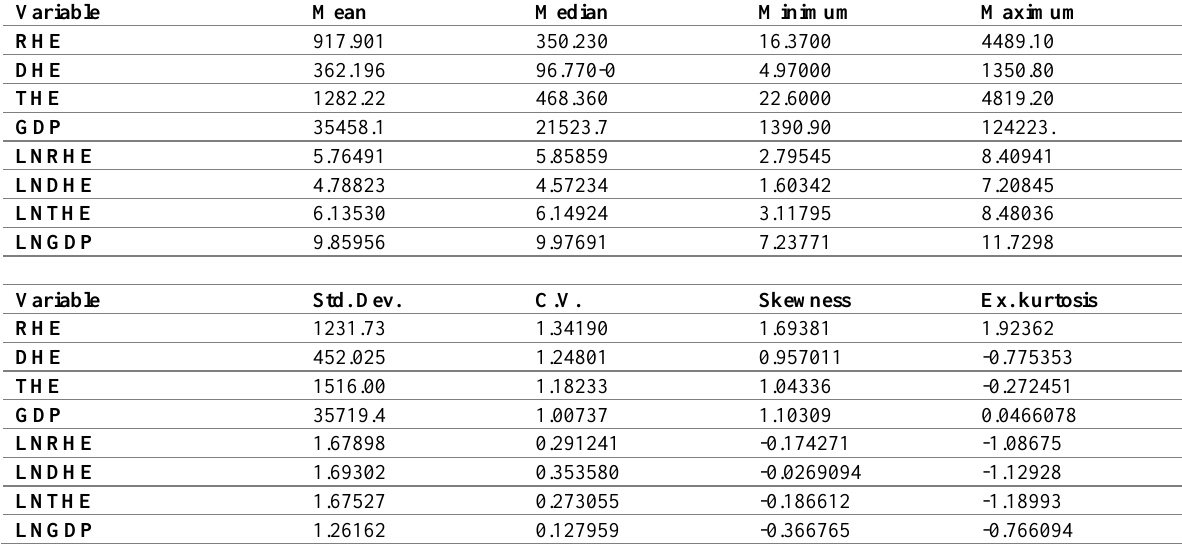
Table 1: Summary Statistics, Using The Observations